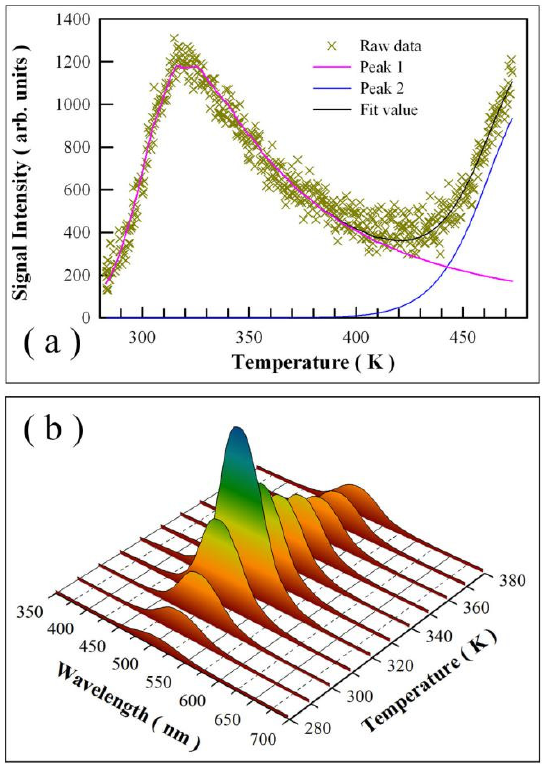
Figure 6. ( a ) Thermoluminescence glow curve of undoped SrAl 2 O 4 and its deconvolution with general order kinetics. The temperature rising rate was 2 K/min. ( b ) Thermoluminescence emission spectrum of undoped SrAl 2 O 4 measured at different temperatures.